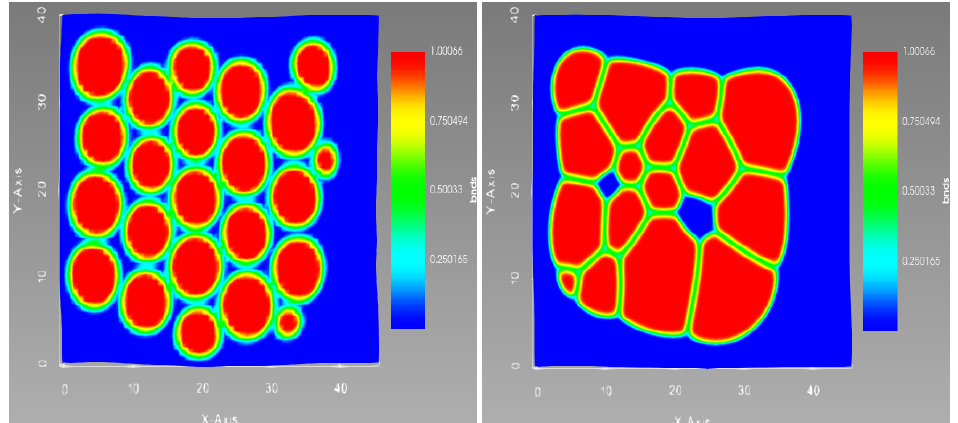
Figure 5. Results of the phase-field simulations of the microstructure evolution for 23 particles, in zero gravity, with periodic boundary conditions. ( left panel) Initial distribution of the 23 “particles”. ( right panel) Distribution of the metal particles in the end of the simulation